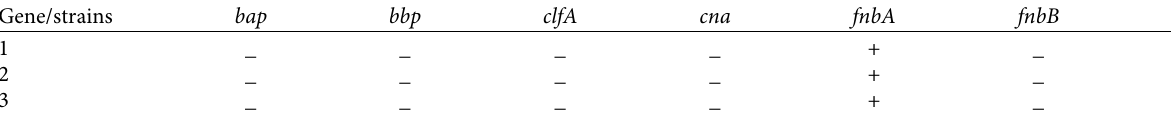
Table 2: Diversity of adhesin genes in the three MRSA strains.